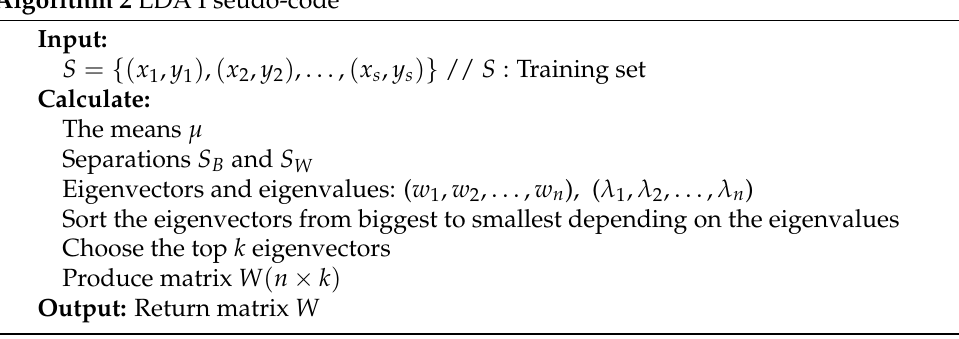
Algorithm 2 LDA